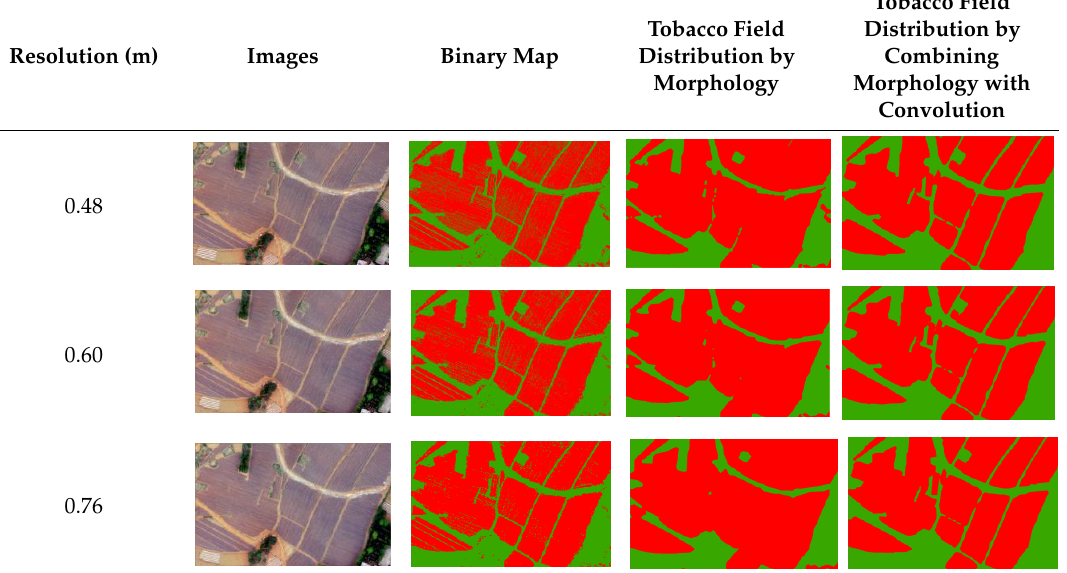
Table 4. Examples of mapping the tobacco field distribution by using different methods. Resolution (m)